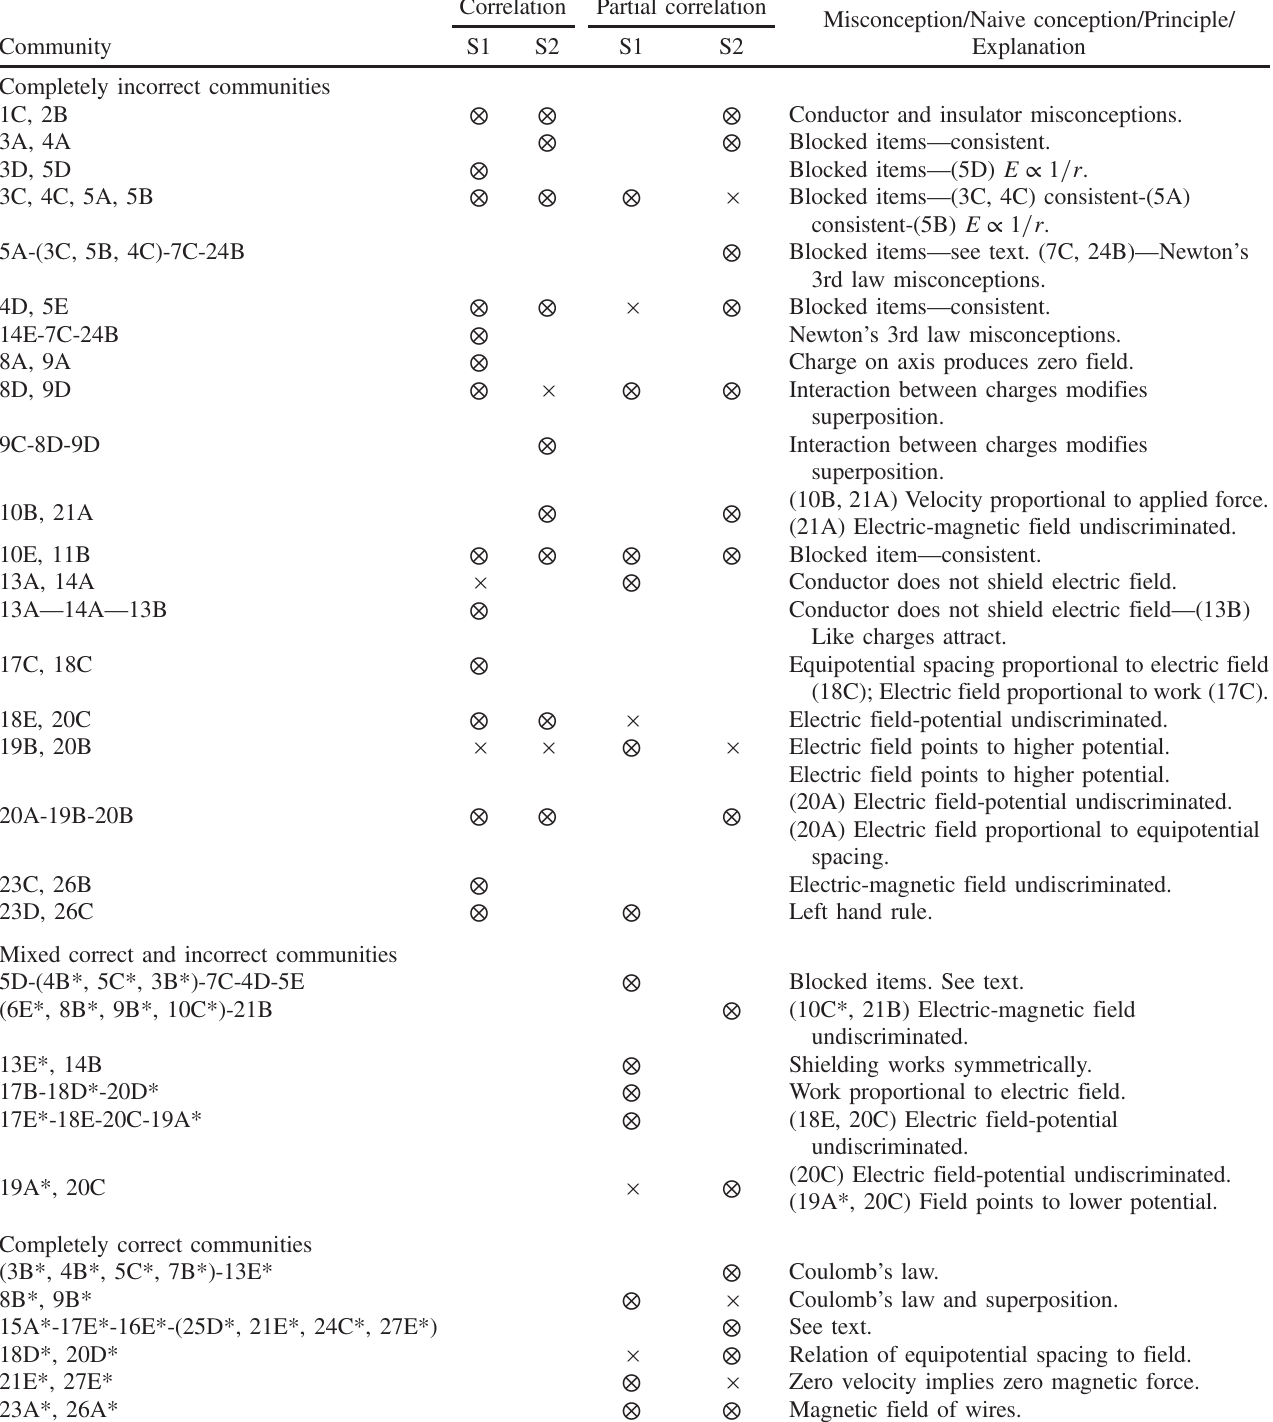
TABLE I. Communities identified in CSEM responses. Communities labeled × are subcommunities of another community. Sample 1 is abbreviated S1; sample 2, S2. Responses in parentheses are completely connected. Responses separated by dashes are only connected to each other. Blocked items are marked consistent if later items apply correct reasoning to an incorrect earlier